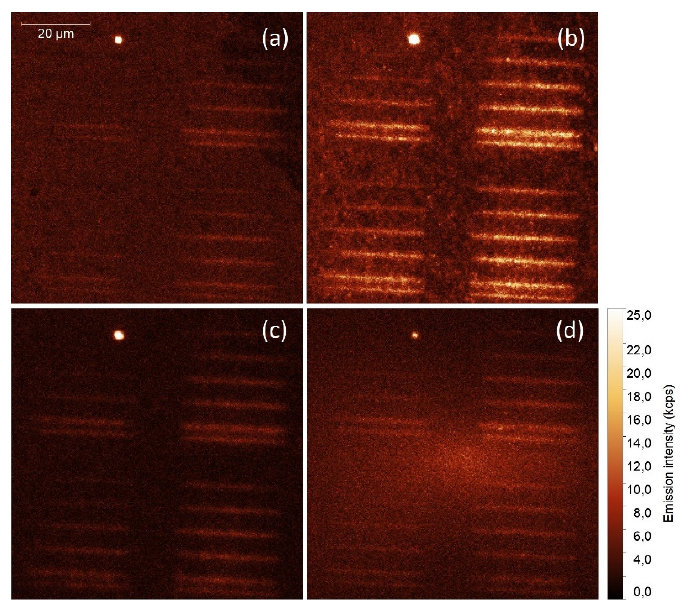
Figure 2. Photoluminescence intensity maps acquired for PCP complexes deposited on a glass substrate with photochemically deposited silver stripes. Excitation wavelengths of: ( a ) 405 nm, ( b ) 480 nm, ( c ) 535 nm, and ( d ) 630 nm were used with the excitation power of 100 μ W.